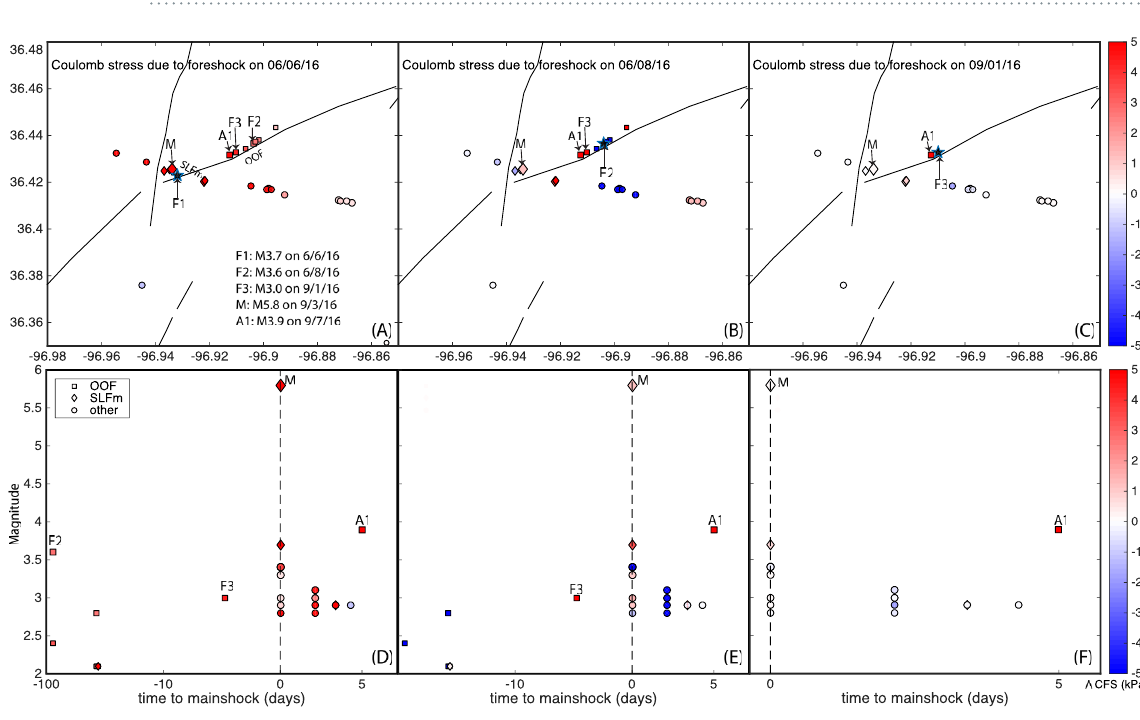
Figure 10. Coulomb stress change on foreshocks, mainshock and early aftershocks due to three M3 + foreshocks. Top row: Map view of Coulomb stress changes due to individual foreshocks. Bottom row: Magnitude versus time view of Coulomb stress changes due to individual foreshocks. The labels of are listed in Figure ( A ). The legend is shown in Figure ( D ). The “OOF” denotes for the conjugate mapped fault, and “SLFm” denotes the segment of Sooner Lake fault ruptured during the mainshock, see Fig.